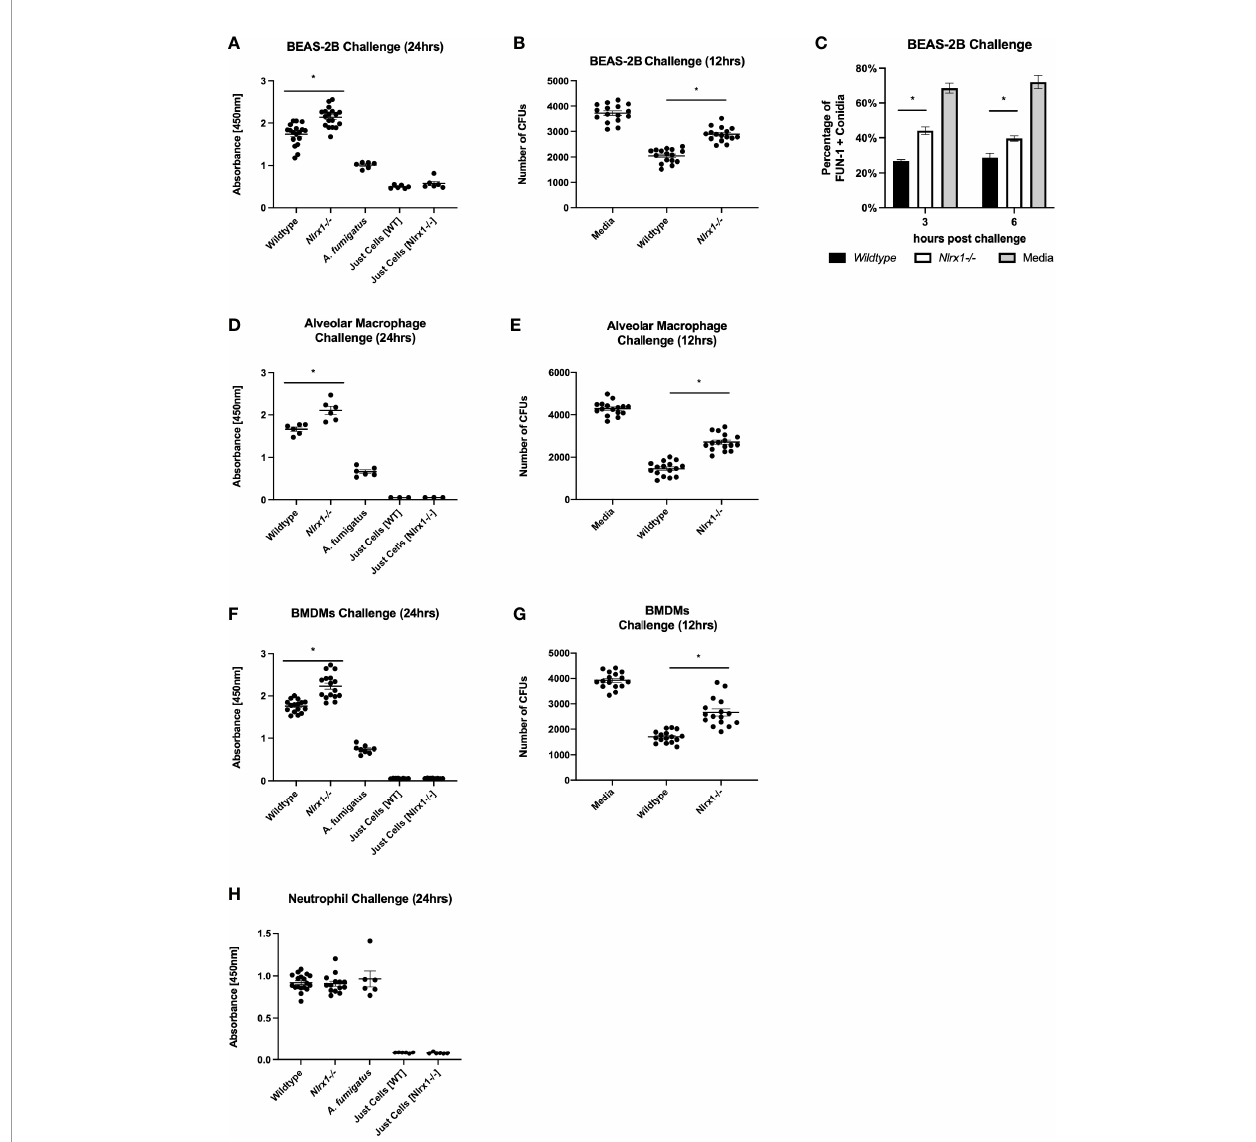
FIGURE 1 | Nlrx1 mediated A. fumigatus processing occurs in a cell-type-speci fi c manner. Viable A. fumigatus conidia were challenged against wild-type and Nlrx1- de fi cient (A – C) BEAS-2B airway epithelial cells, (F, G) bone marrow-derived macrophages, (D, E) alveolar macrophages, and (H) bone marrow-derived neutrophils. Conidial viability was assessed via (A, D, F, H) XTT viability assay 24 h post challenge, (B, E, G) the colony-forming unit assay 12 h post challenge, and (C) FUN-1+ fl uorescence assay 3 h post challenge. p < 0.05, indicated by asterisk via Kruskal – Wallis test followed by a Dunn ’ s test for multiple